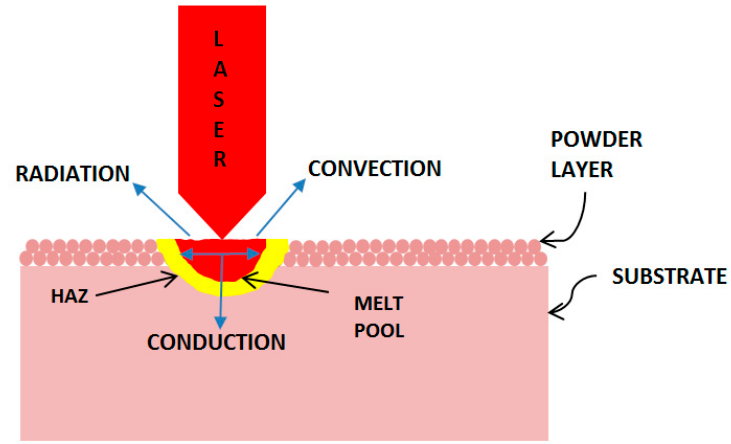
Figure 2. Schematic of energy transport mechanisms in the laser processed zone .